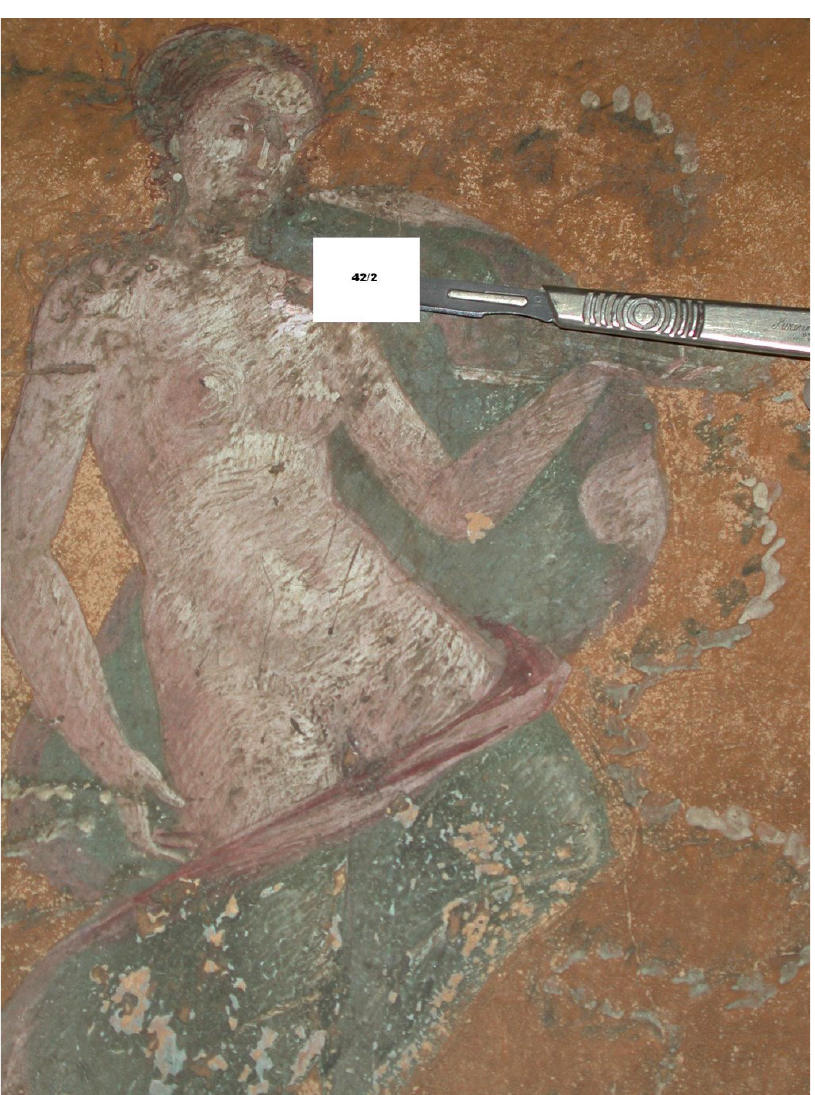
Figure 1. The picture of Season in room 42 (the antechamber of the so-called erotic cubiculum) of Insula del Centenario, Pompeii, Italy, where sample 42/2 was collected.